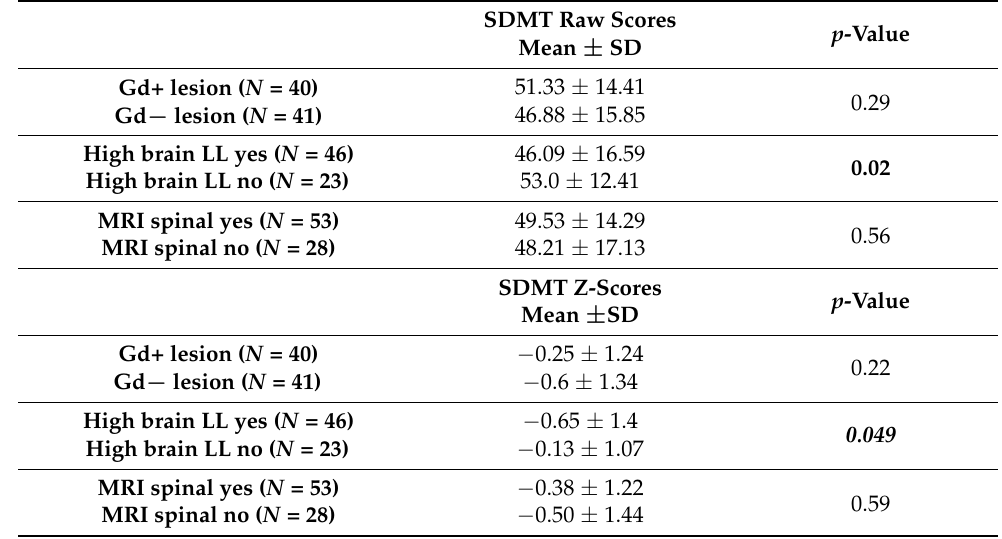
Table 2. Between-group differences in SDMT and radiological characteristics ( N = 81).